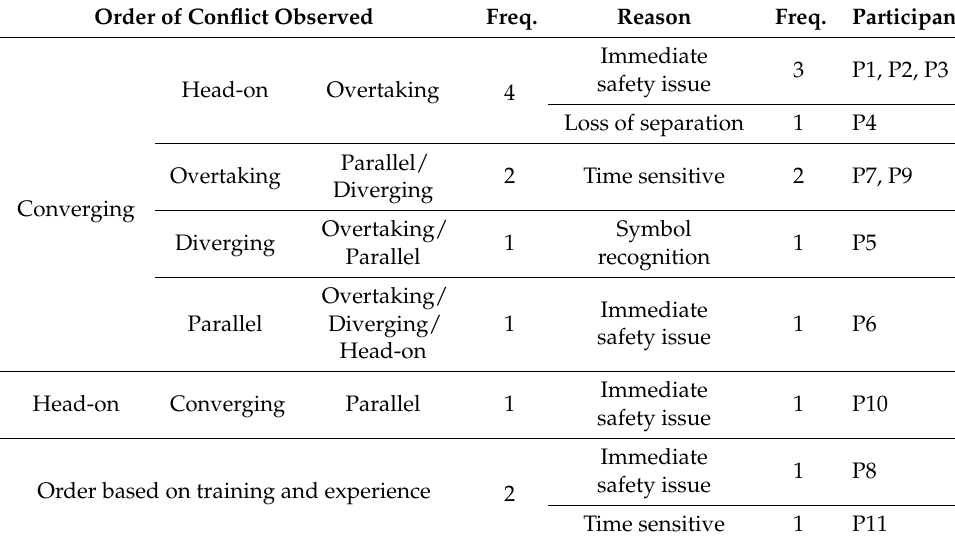
Table 7. Priority order of aircraft conflict types and their associated reason.